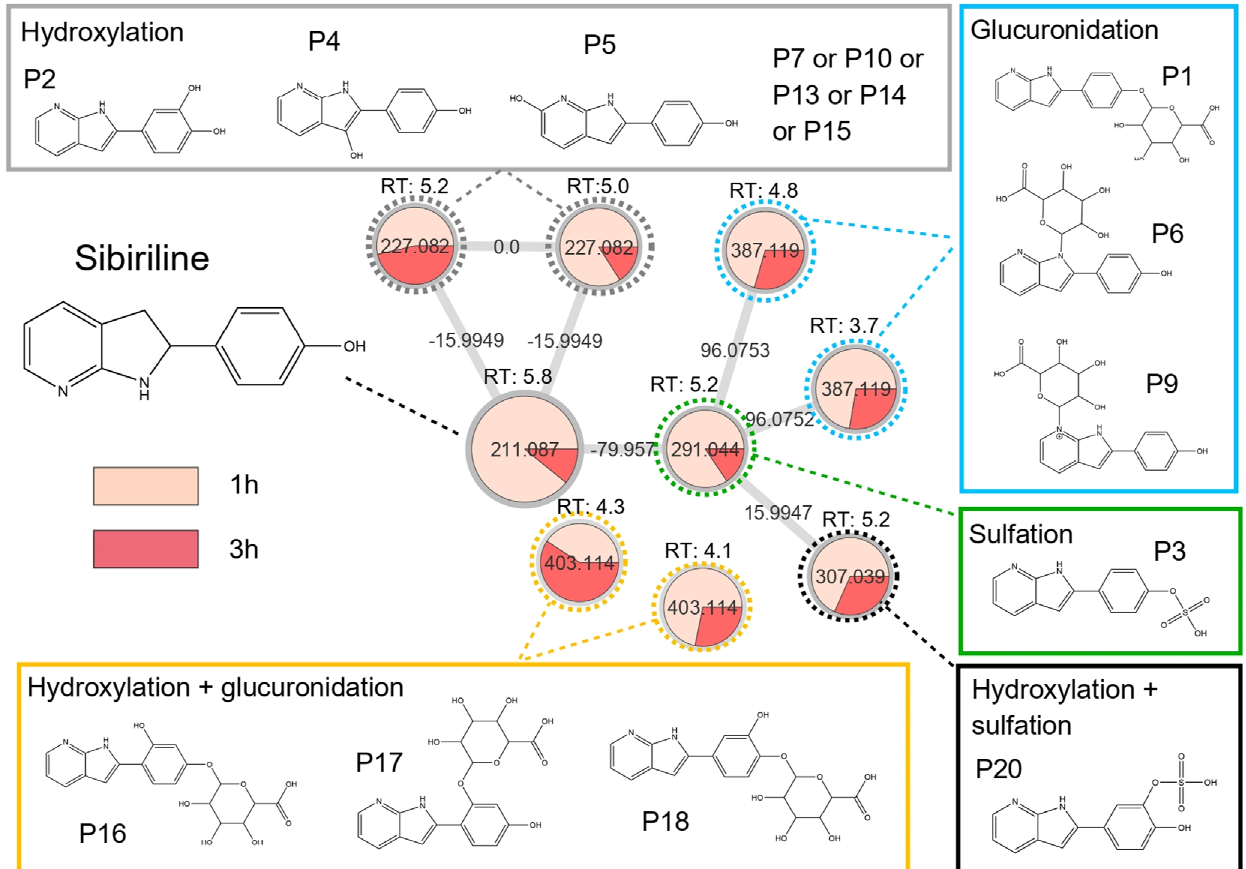
Figure 4. In vivo Sibiriline metabolism kinetic. Mice plasma sample collected 1 h or 3 h after intraperitoneal injection of Sibiriline (5 mg/kg) were analyzed using LC-HRMS/MS. In this sibiriline-containing cluster, each type of biotransformation reaction was depicted in different colors (glucuronidation in bleu, sulfation in green, oxidation + glucuronidation in yellow, and oxidation/hydroxylation in grey). Nodes are labelled with the exact protonated mass ( m/z ), putative chemical structures and the links are labelled with the exact mass shift. RT = retention time in minute.